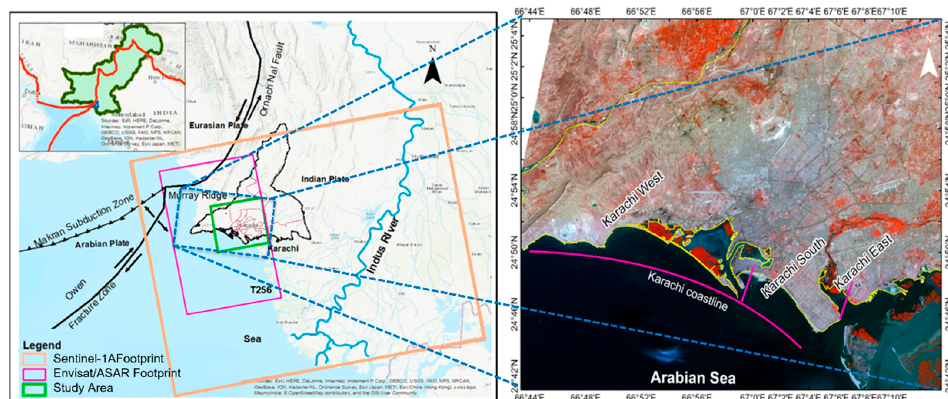
Figure 1. Inset (left) maps the location of the coastal mega-city of Karachi relative to the Arabian- Indian-Eurasian plates’ tectonic triple junction. The green box marks the coverage of the study area, for which 33 scenes from ENVISAT/ASAR (2004–2010), 23 images from Sentinel-1A (2014–2016), and 4 images of Landsat (1989–2018) are processed. Each administrative unit along the Karachi coastline is represented on the right, overlaid upon a Landsat Operational Land Imager (OLI) false color image (2018).